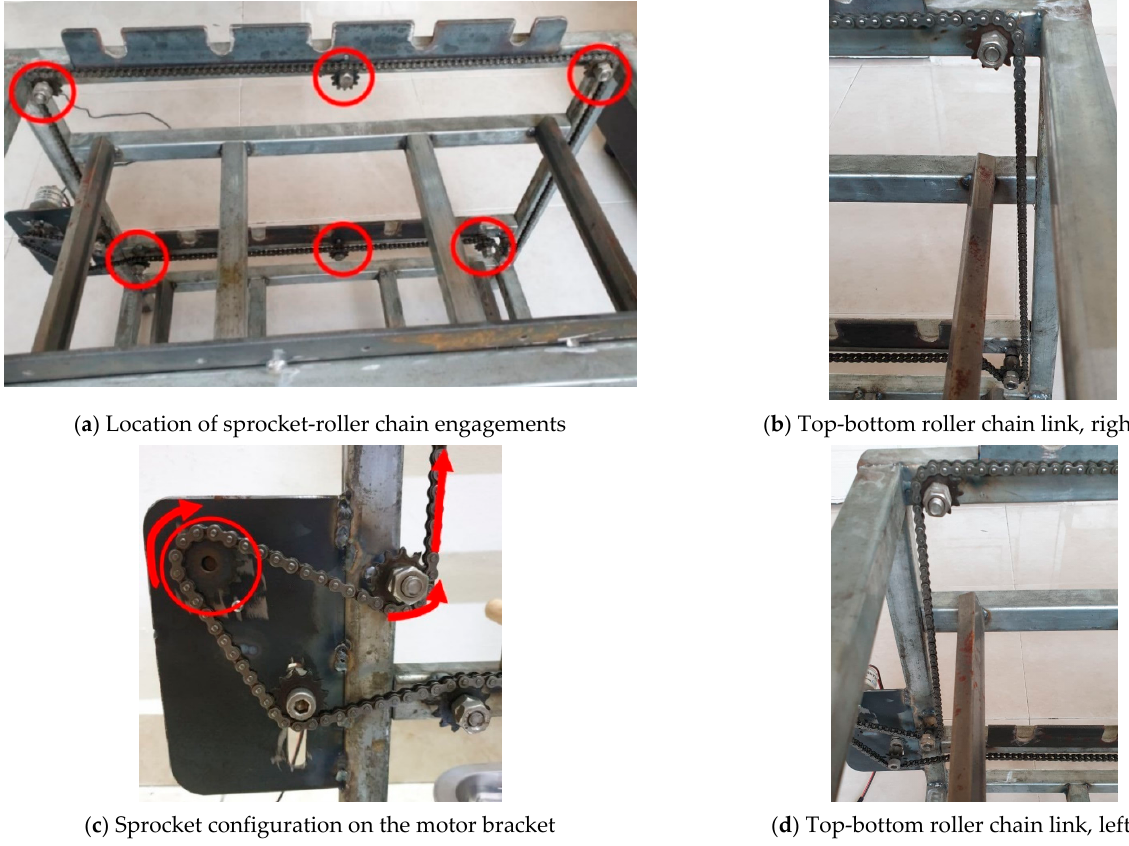
Table 10. Specifications of the